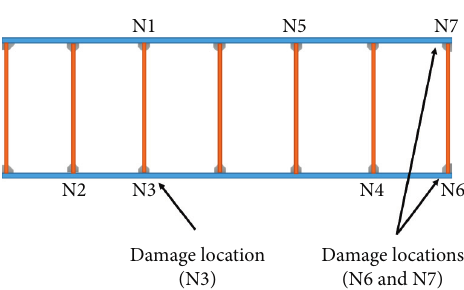
Figure 2: Node numbers for the steel grid